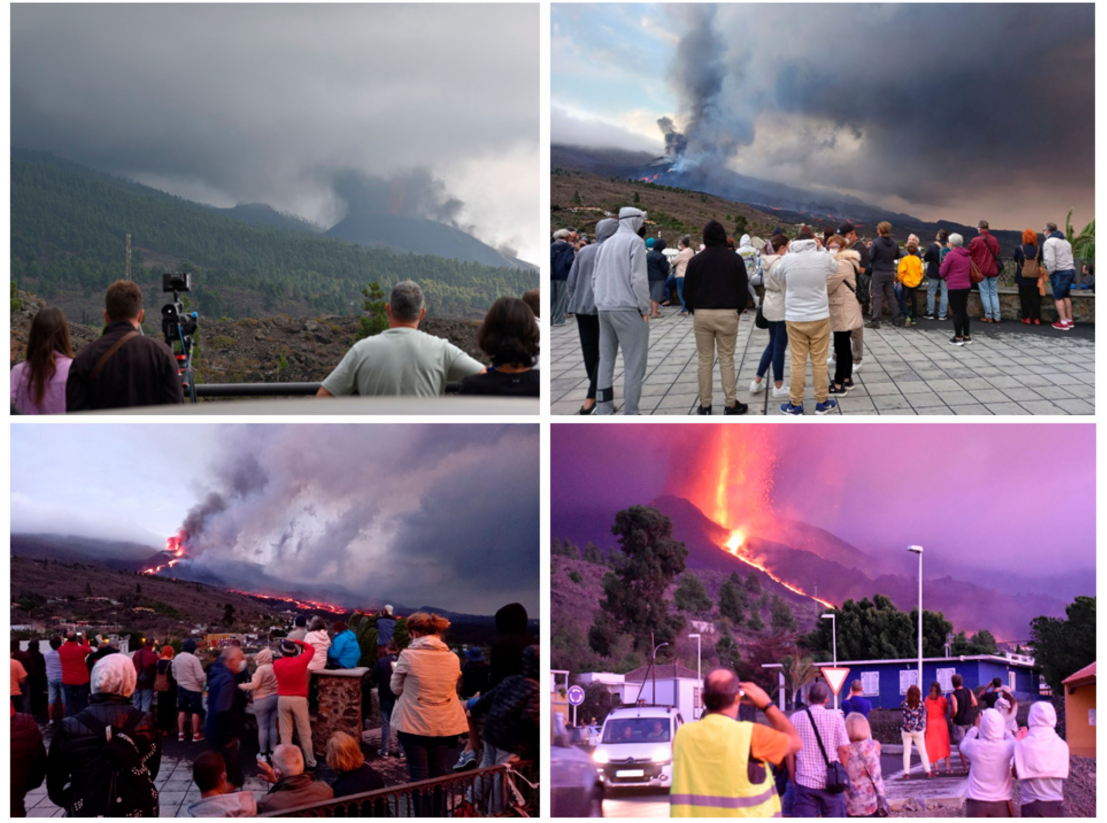
Figure 4. Visitors watching the eruption, La Palma (Spain). Source: